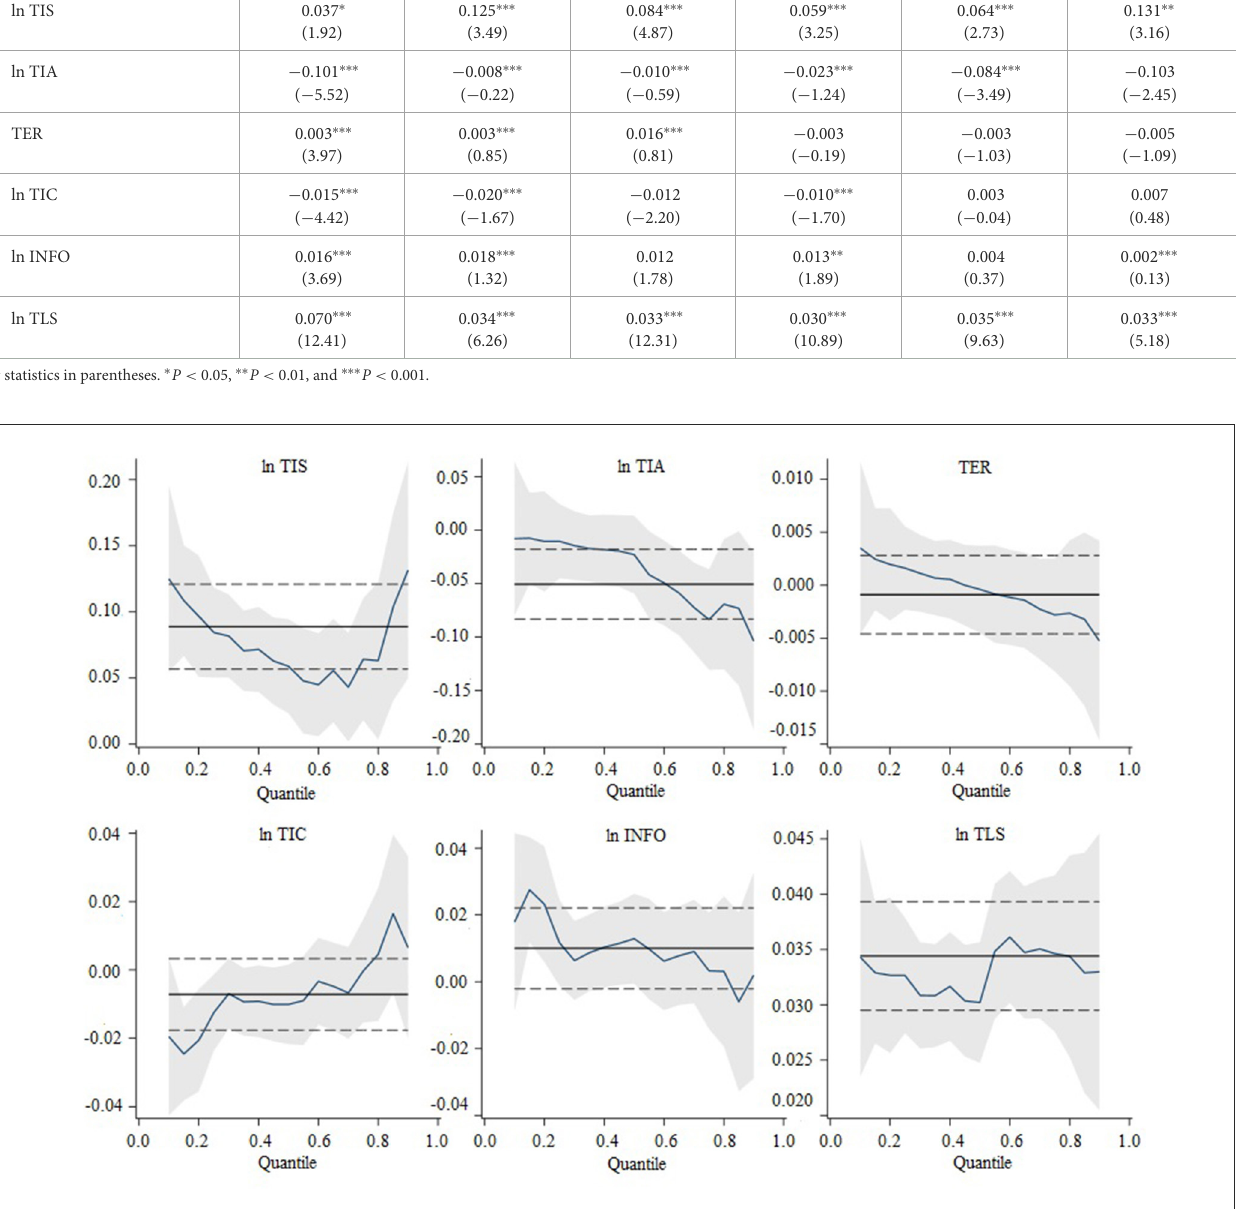
coefficients for the first 50% of the quantile being significantly larger than those for the second 50% of the